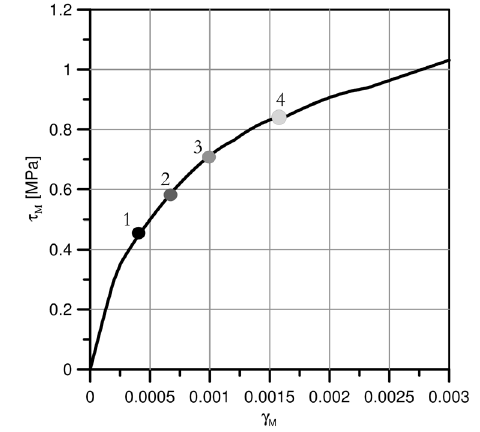
Figure 11: Example 2: